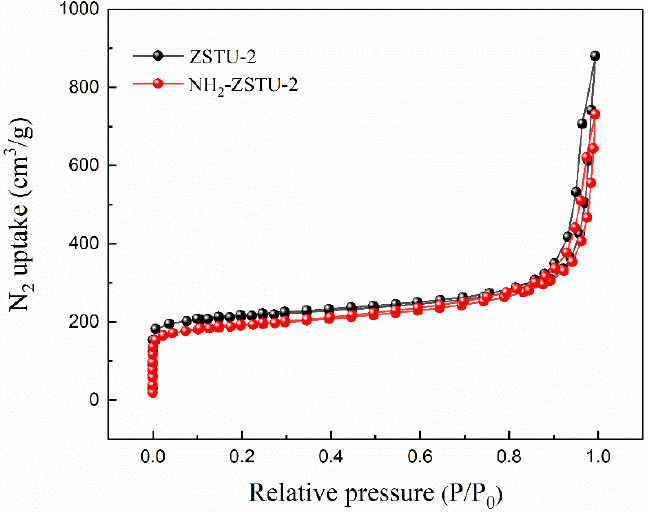
Figure 4. Nitrogen sorption isotherms of ZSTU-2 and NH 2 -ZSTU-2.